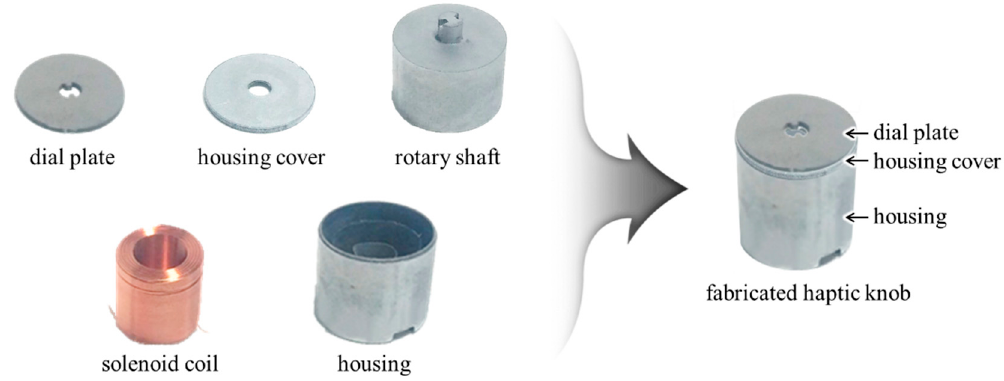
Figure 8. Components and prototype of the proposed actuator.